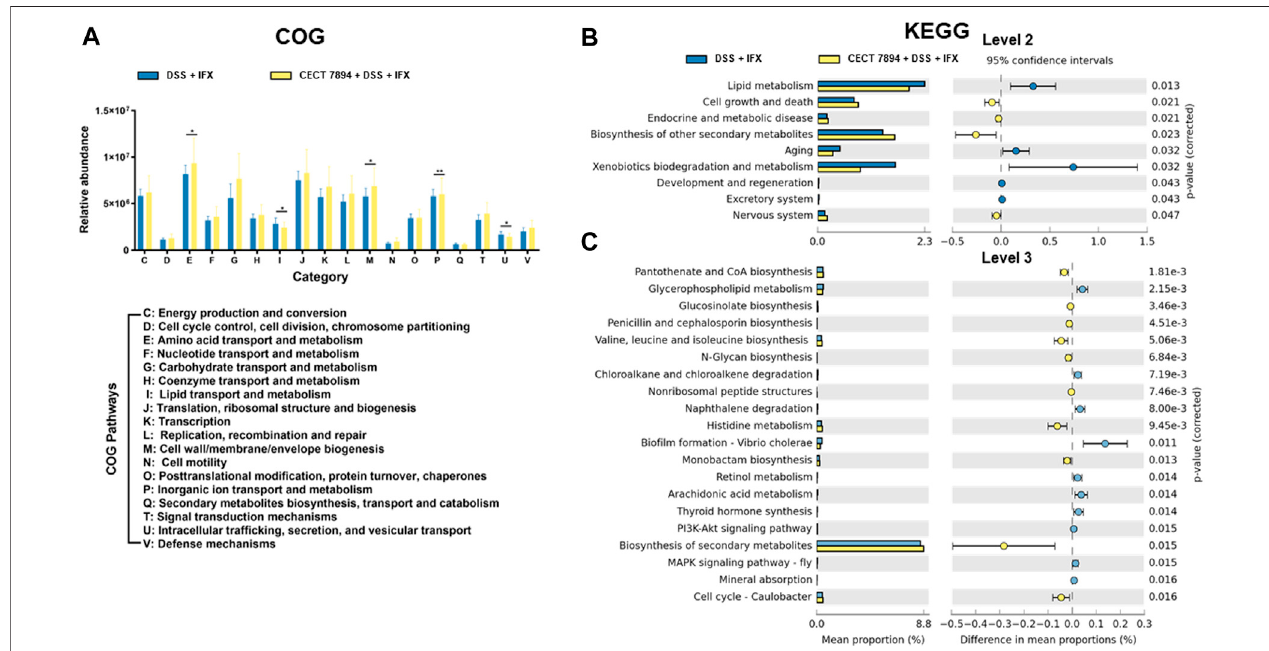
FIGURE5 | Functional pro fi les ofthe gut microbiome. (A) Analysis offecal microbiome on COG pathways. Analysis ofthe fecal microbiomeon KEGG pathwaysat level 2 (B) and level 3 (C) . Signi fi cance is determined by using the Welch ’ s t-test, with * p < 0.05, ** p ≤ 0.01, *** p ≤ 0.001.